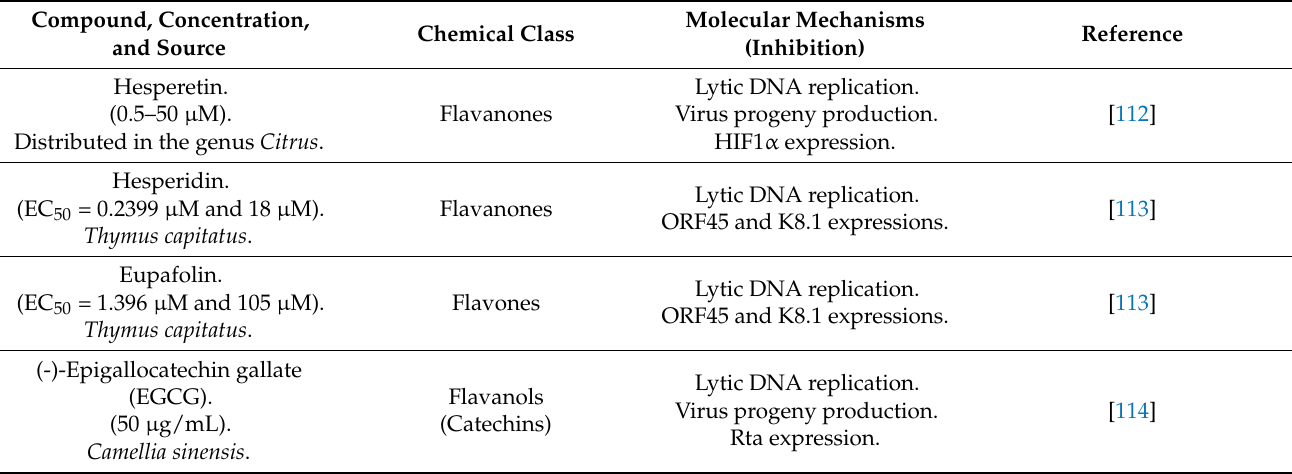
Table 2. Flavonoids with anti-KSHV properties and their molecular mechanisms evaluated in